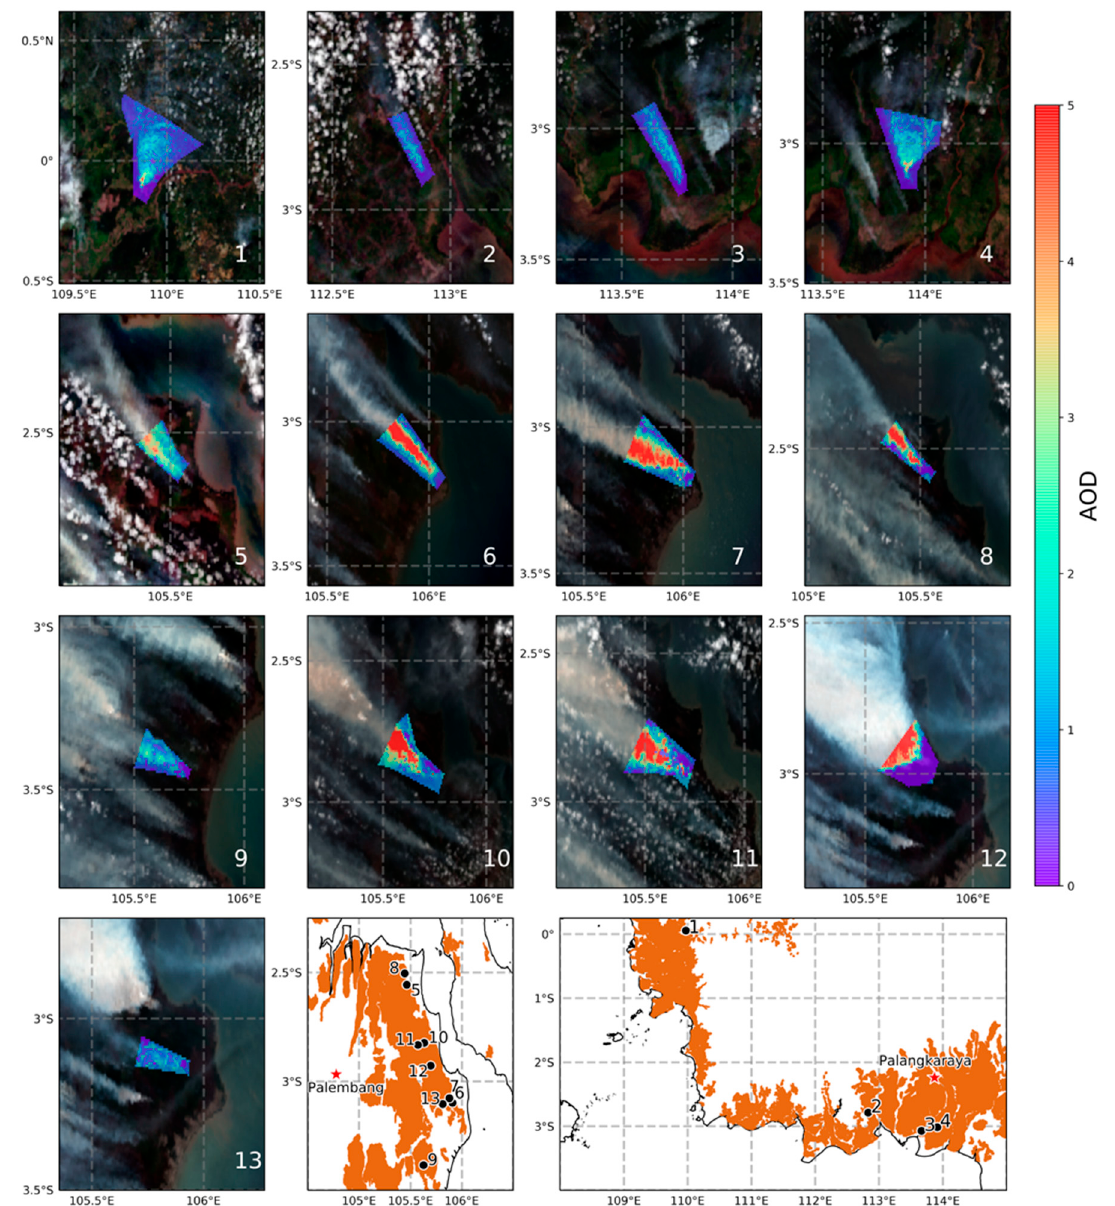
Figure 2. Plumes and overlain aerosol optical depth (AOD) from the thirteen highly radiant peatland fires on Sumatra and Kalimantan burning between July and October 2015, which provided our matchup dataset. The two inset maps show the location of each plume on Sumatra (first map) and Kalimantan (second map), with peatland areas shaded according to Global Forest Watch (http://data.globalforestwatch.org/datasets/).